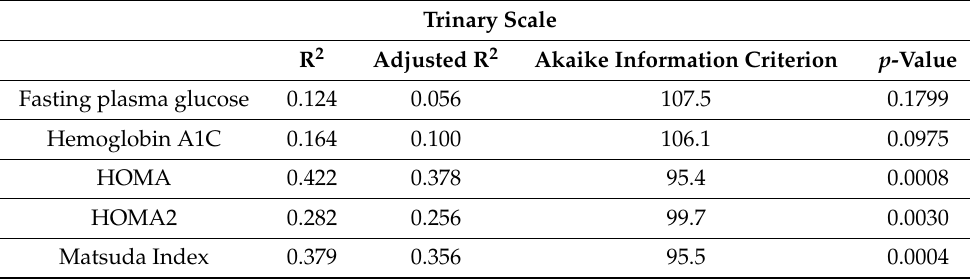
Figure 2. Dot plots of the non-scaled, log-transformed insulin sensitivity (Si) value by the insulin resistance and diabetes classifications of the six indices (n = 29). Fasting plasma glucose (FPG) and Hemoglobin A1C (HbA1C) utilize a normal (N), prediabetes (PD), and diabetes (D) classification scale. The Homeostatic Model Assessment for Insulin Resistance (HOMA) uses a normal (N), early insulin resistance (EIR), and significant insulin resistance (SIR) classification scale, while the Homeostatic Model Assessment 2 for Insulin Resistance (HOMA2) utilizes a normal (N) and insulin resistance (IR) classification scale. The Matsuda Index and Quantitative Insulin-sensitivity Check Index (QUICKI) use a normal (N) and insulin resistance (IR) classification scale, and the latter also uses a classification of diabetes (D). Table 4. Linear regression models between the non-scaled, non-log-transformed Si value and each of the classifiers from the six